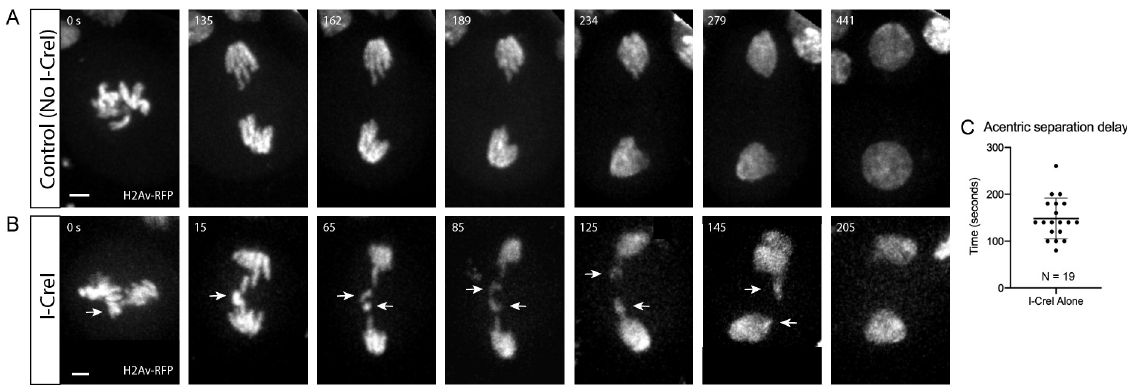
Fig 1. Acentric sister separation is delayed relative to kinetochore-bearing chromosomes during anaphase. (A) Still frames of a time-lapse movie of a mitotic neuroblast labeled with H2Av-RFP and not expressing I-CreI. (B) Still frames of a time-lapse movie of a mitotic neuroblast with I-CreI induced acentrics. Separation of sister acentrics (arrows) is delayed. Consequently, they lag on the spindle equator but eventually separate, segregate, and are reincorporated into daughter nuclei. Bars, 2 μ m. Time in seconds. (C) Scatterplot showing the delay in acentric sister separation after anaphase onset. Delay (seconds) was measured from when kinetochore-bearing chromosomes initiated separation to when acentric sister chromosomes initiated separation. Bars represent mean and standard deviations.